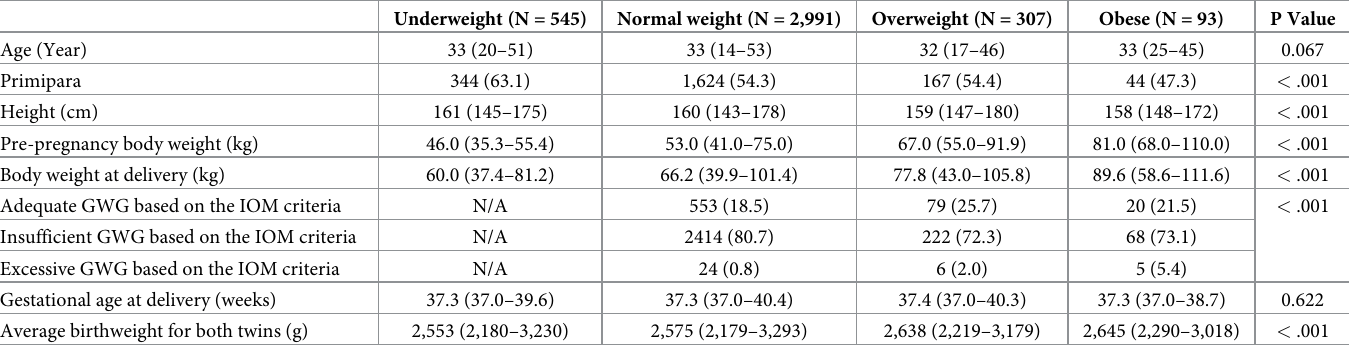
Table 1. Maternal background characteristics and pregnancy outcomes for cases in which both twins were classified as appropriate for gestational age. Underweight (N = 545) Normal weight (N =